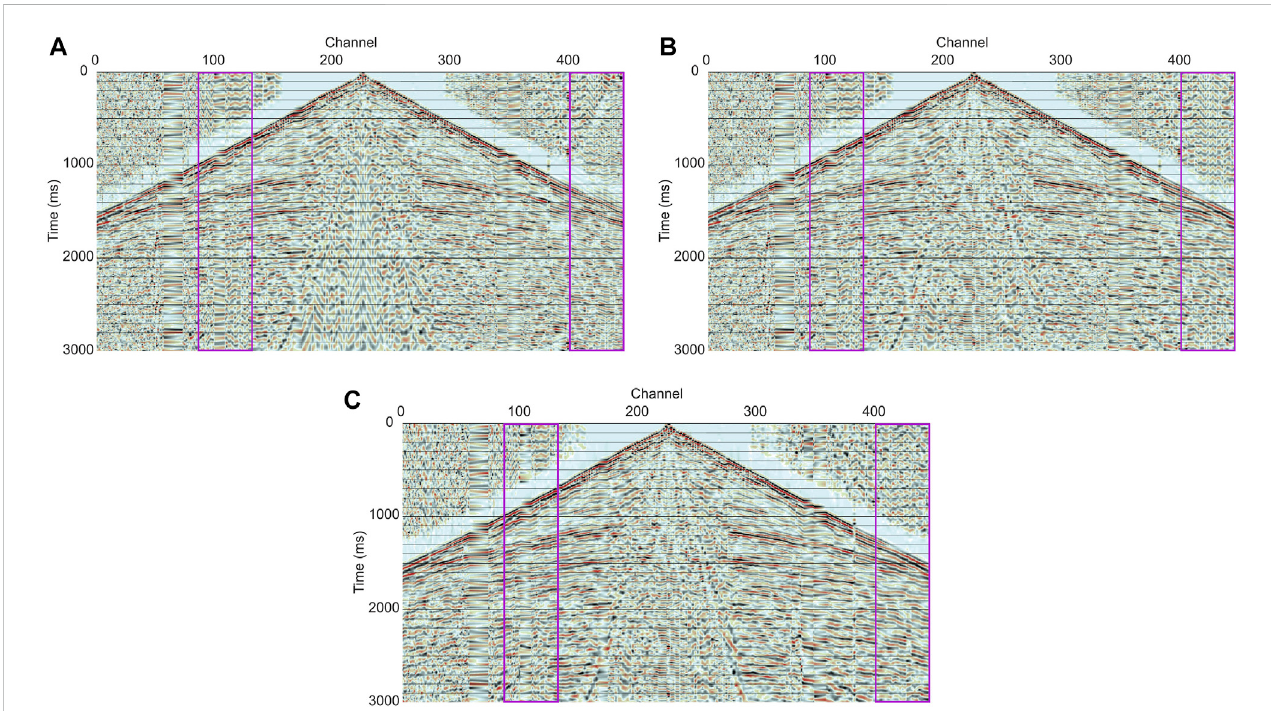
FIGURE 11 (A) Example of fi eld data in a CMP gather and the corresponding denoising results of (B) the processing fl ow and (C) the fl ow with the U-net denoising step. Two magenta boxes indicate the locations of the pumpjack noise. The traditional processing fl ow can improve the continuity of the re fl ection signals contaminated by the pumpjack noise; because the frequency range of the signal and noise overlap, some fl at noise remains. However, if the U-net denoising step is applied, the fl at noise does not exist.